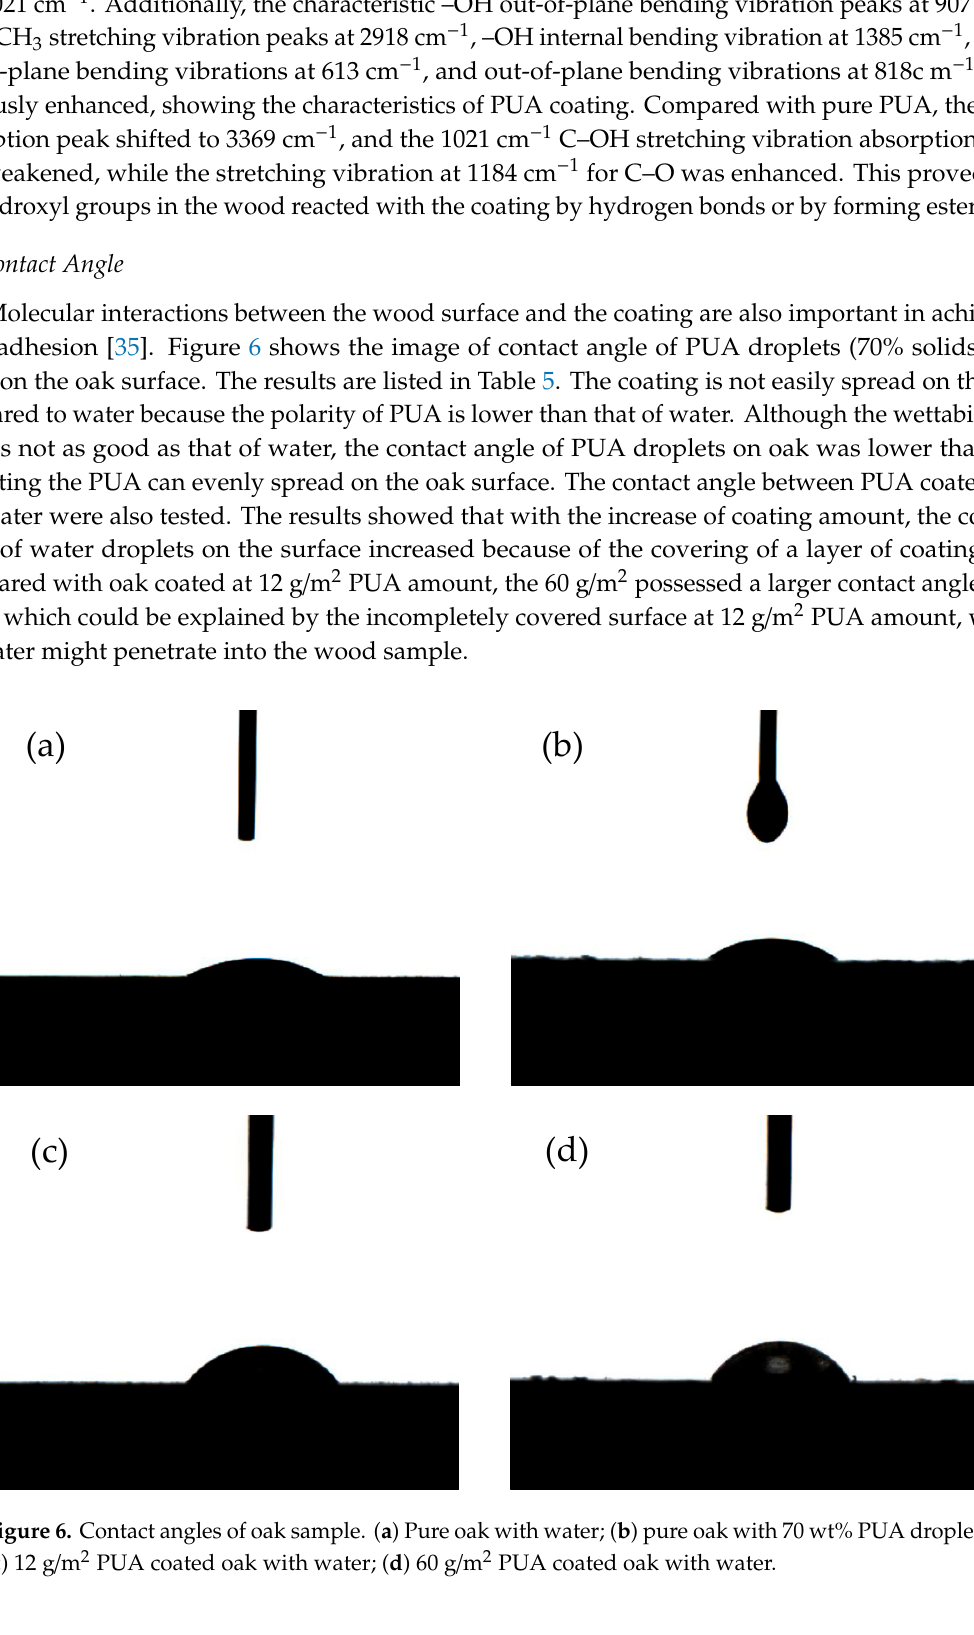
Figure 5. ATR-FTIR spectrum of samples. ( a ) Pure oak and PUA coating; ( b ) oak before and after coating with different coating amounts.